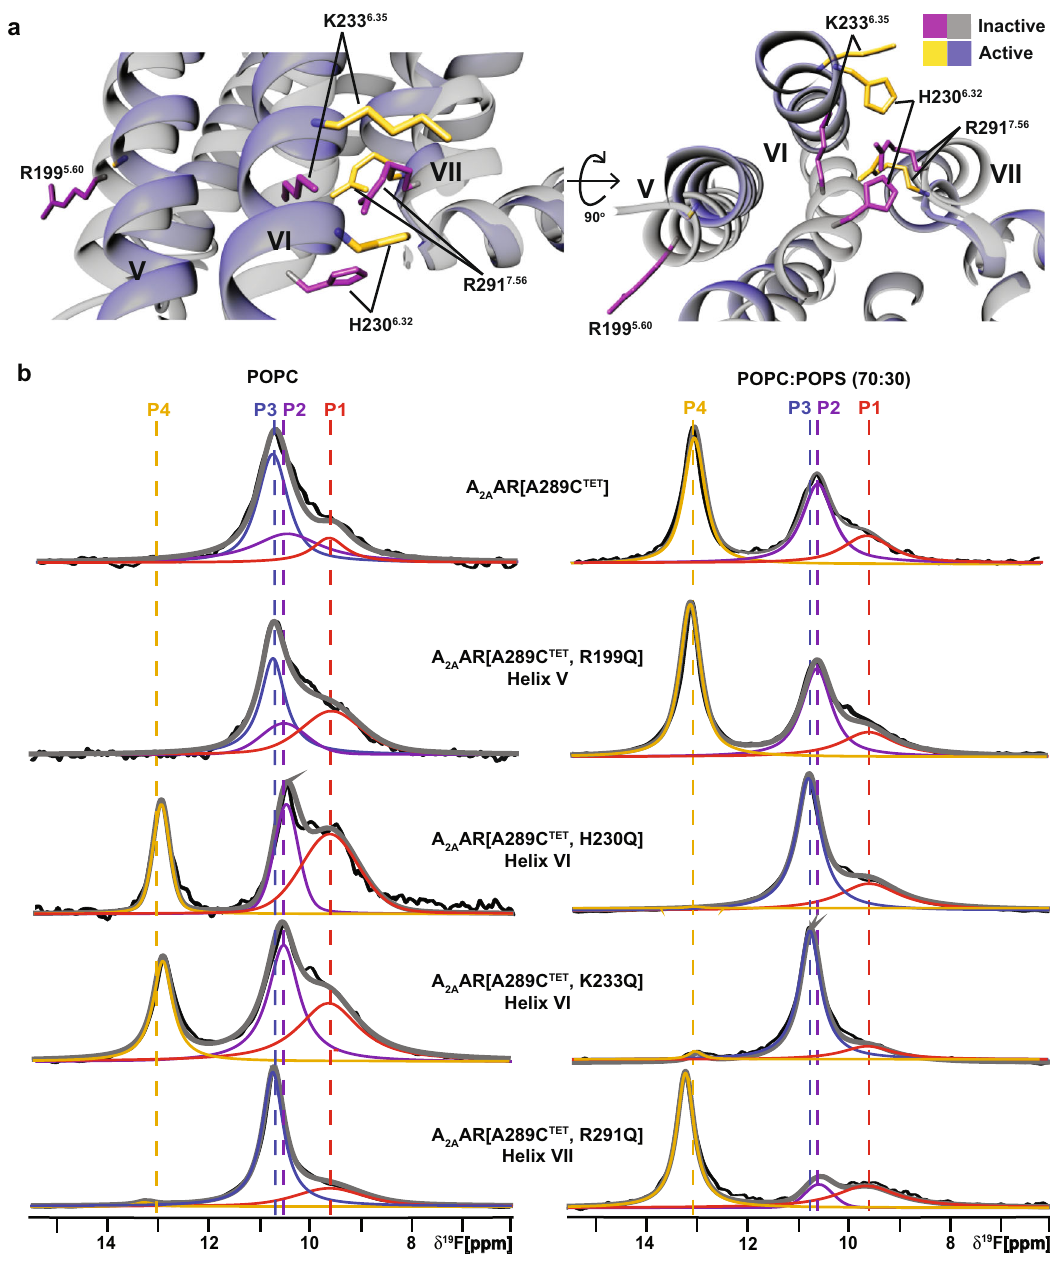
Fig. 4 | Impact of positively charged amino acids near the intracellular sig- naling on NMR response to anionic lipids. a Location of several charged amino acids near the lipid bilayer boundary. b 19 F-NMR spectra of A 2A AR[A289C TET ] and several A 2A AR variants in complex with the agonist NECA in lipid nanodiscs